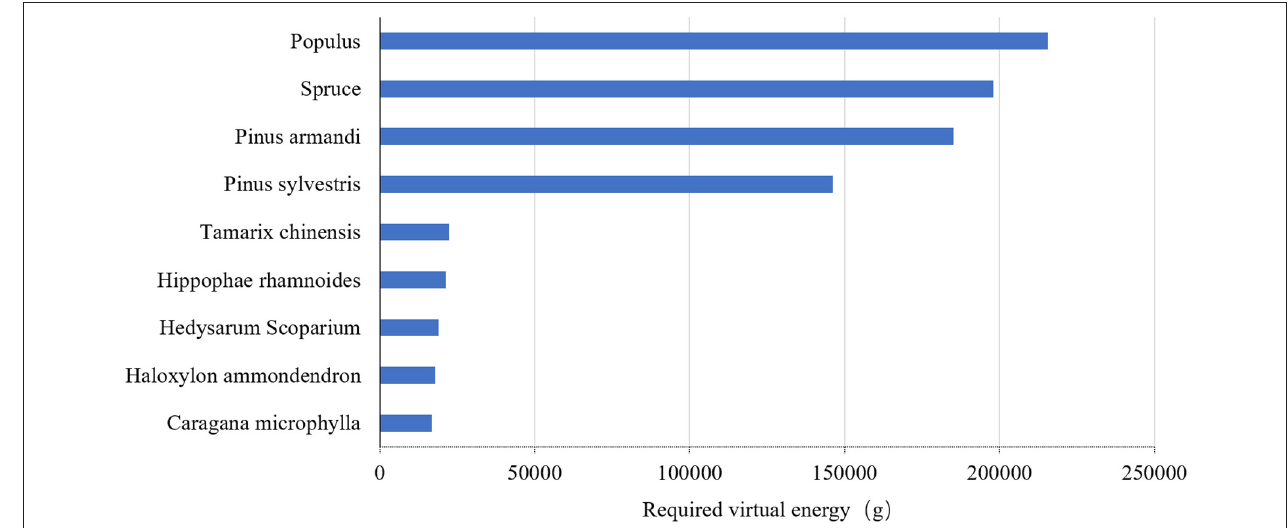
FIGURE 1 | The required virtual energy used to exchange offline real tree species.